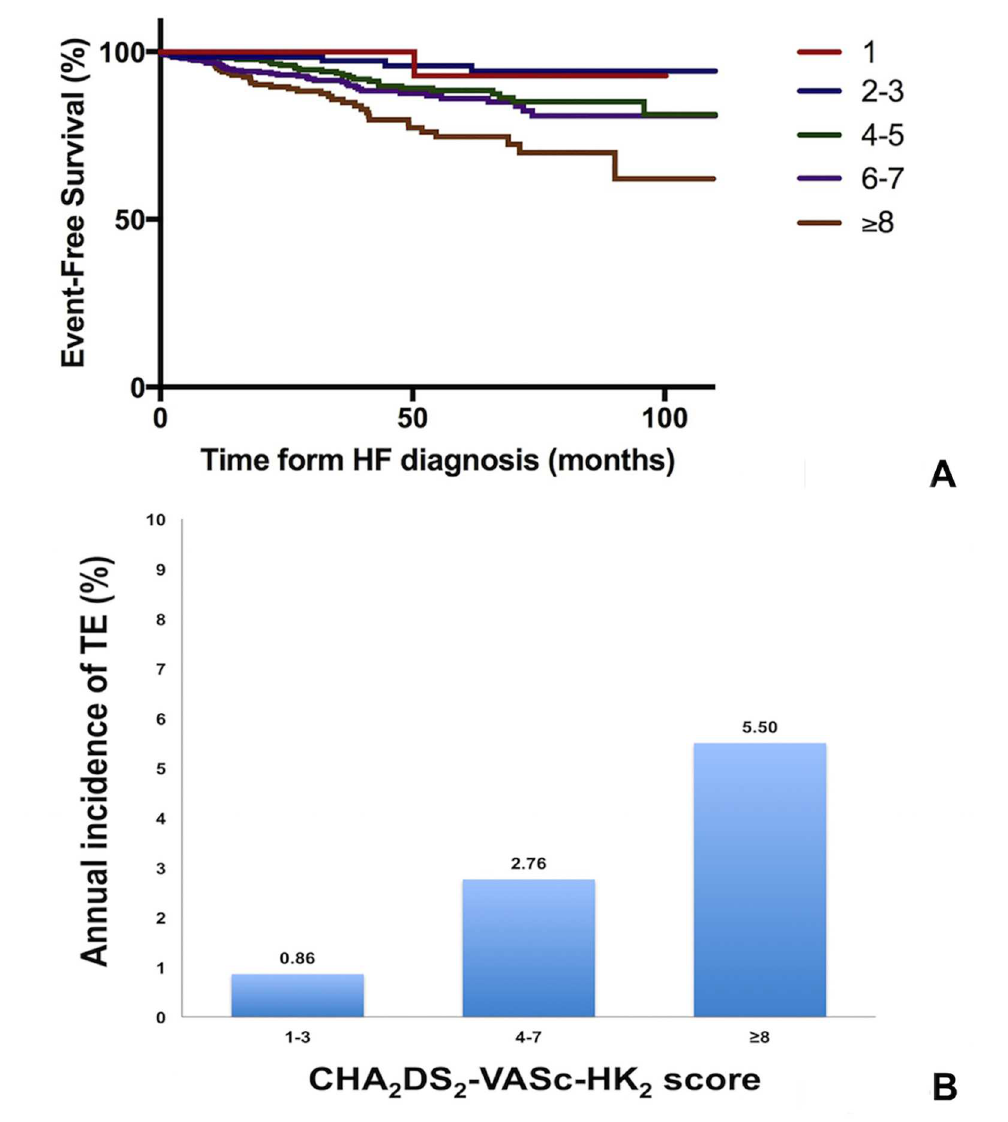
Fig 4. Risk of thromboembolic events among heart failure patients in sinus rhythm according to their CHA 2 DS 2 -VASc-HK 2 score. (A) Kaplan-Meier curves for thromboembolic event-free survival. Log-rank: 25.896. P < 0.001.(B) Annualincidenceof thromboembolic events. CHA 2 DS 2 -VASc-HK 2 = 1–3: 0.86% per year (95% CI 0.78–0.96); CHA 2 DS 2 -VASc-HK 2 = 4–7: 2.76% per year (95% CI 2.61–2.92);CHA 2 DS 2 -VASc-HK 2 (cid:21) 8: 5.50% per year (95% CI